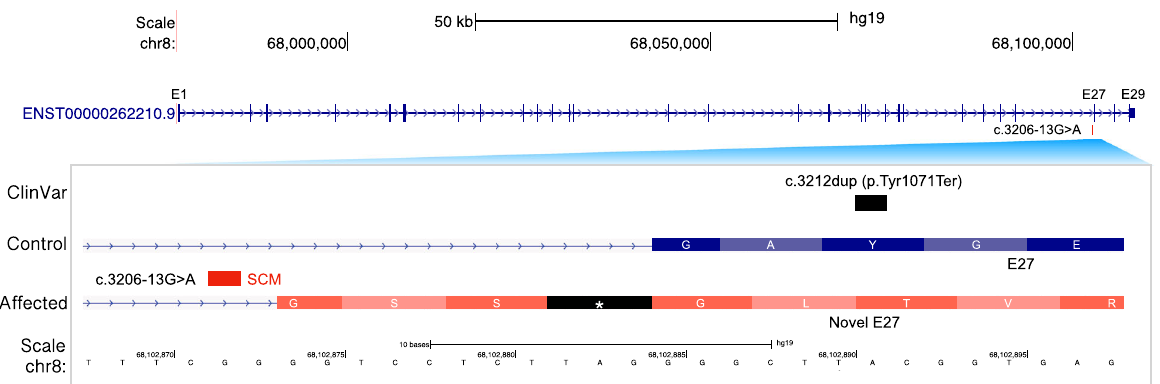
Fig. 5 Schematics of exon extension by SCM found in CSPP1 . The upper panel shows the gene structure of CSPP1 obtained from the gene annotation data of GENCODE 48 v24. The lower panel is a close-up view of the SCM and exon 27 (E27). The ClinVar track shows a known pathogenic variant, c.3212dup, for ciliopathy. The gene structure for a control individual is followed by that for an affected individual with the SCM (c.3206 – 13 G > A) which induces an exon extension. The extended exon contains an in-frame stop codon, shown as an asterisk with a black